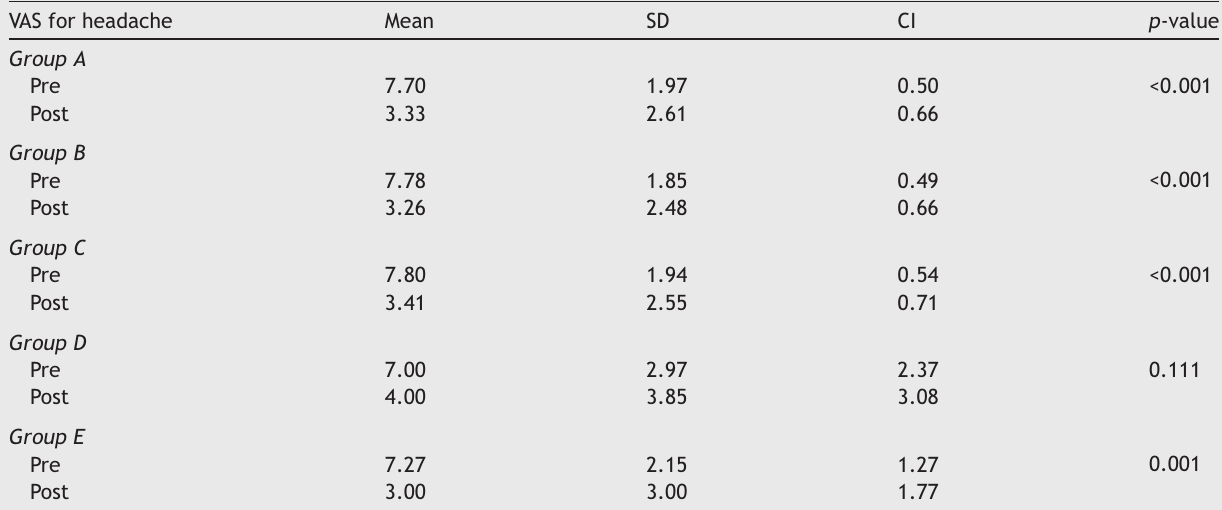
Mean scores of the visual analogue scale for headache by subgroup of